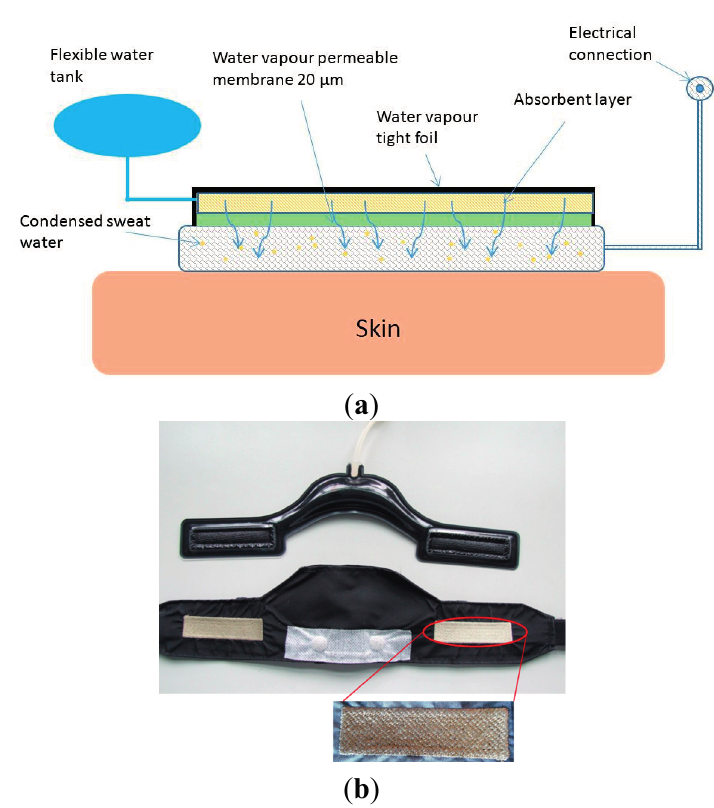
Figure 2. ( a ) Sketch of the wetting device; ( b ) Prototype of the wetting pad ( above ) and the ECG belt with embroidered electrodes ( below